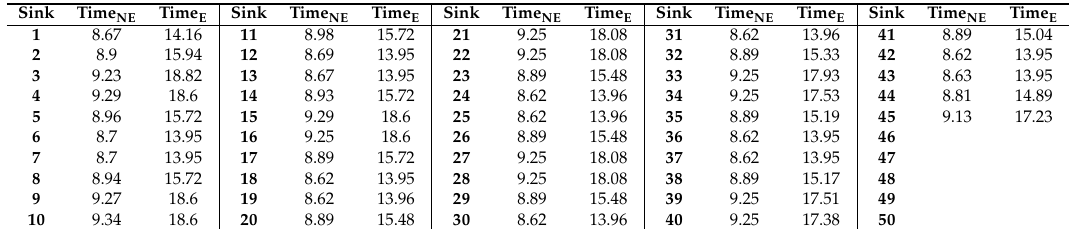
Table 7. Scenario 4: transmission times (in s) for each sink all over the transmission line. (Distance between poles is equal to 100 m, κ = 8, η = 3, NE means no encryption, E means encryption.)